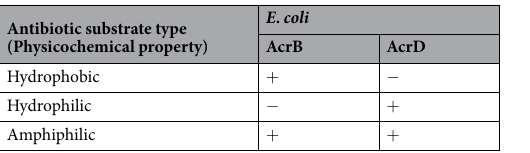
Antibiotic substrate type (Physicochemical property)